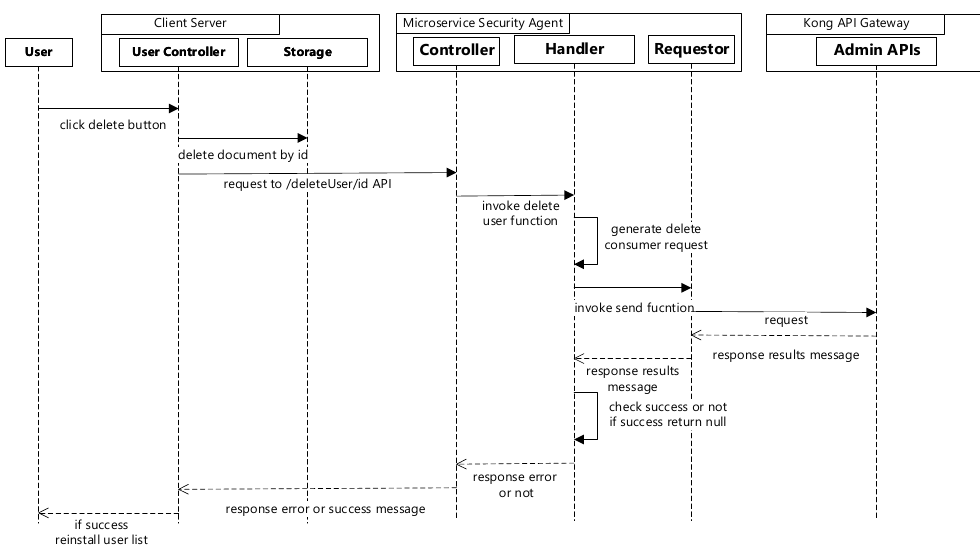
Figure 5. Sequence diagram for user